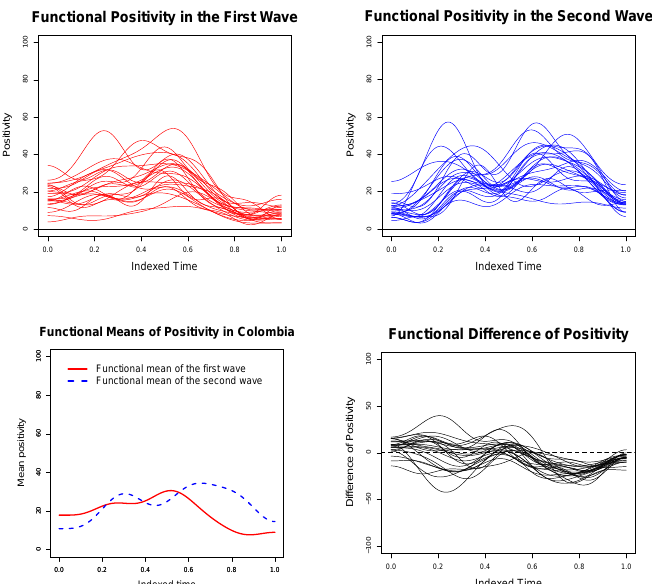
Figure 5. Functional positivity data for COVID-19 in Colombia for Case 2: Functional positivity in the first wave ( top left ); functional positivity in the second wave ( top right ); functional means of positivity in the first wave in solid line and the second wave in dashed line ( bottom left ); positivity difference curves ( bottom right